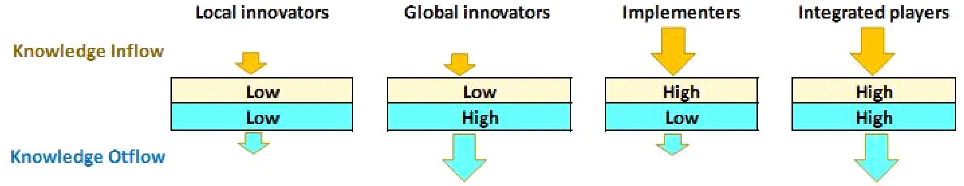
Figure 2. Strategic mandates of subsidiaries in knowledge transfer in MNCs. Source: Authors’ representation Adapted from [23], p 59.